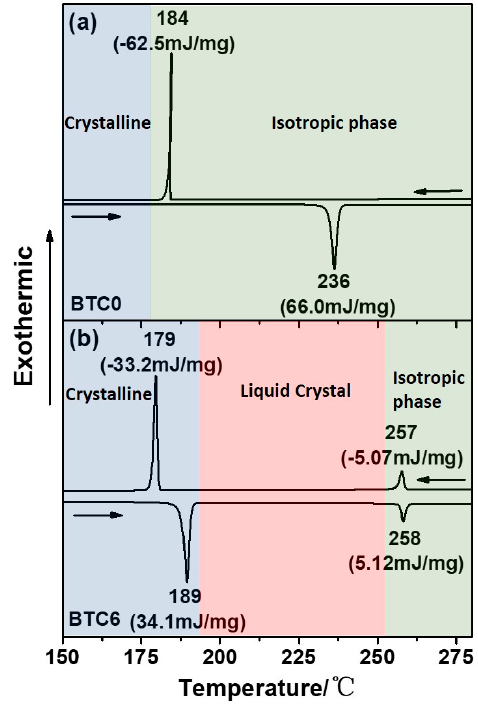
Figure 5. Differential scanning calorimetry (DSC) spectra of BTC0 ( a ) and BTC6 ( b ). The traces were measured at 20 °C/min and the second heat-cooling cycles were used.